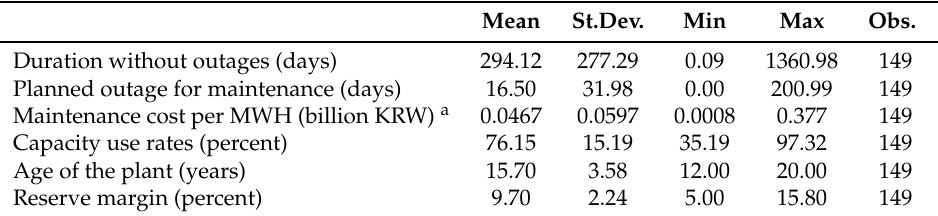
Table 1. Descriptive statistics—Combined cycle power